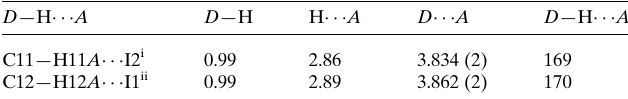
Table 2 Hydrogen-bond geometry (A˚ , (cid:4) ) for 2 .